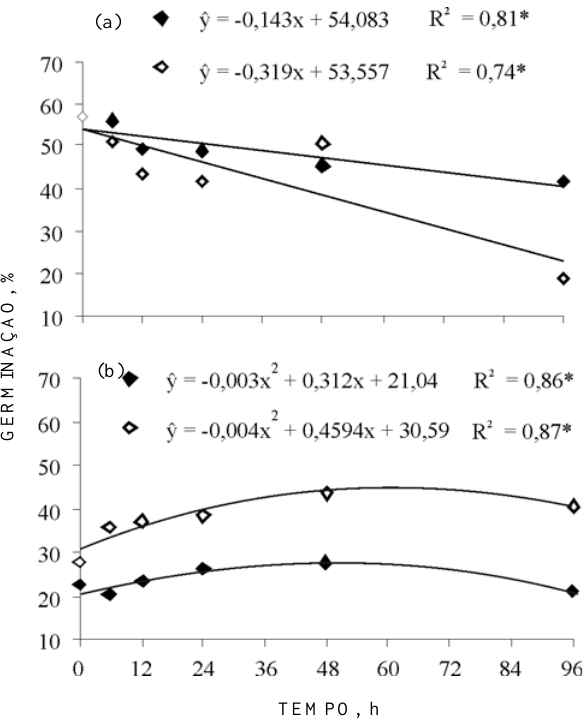
Figura 1. Germinação de sementes de Brachiaria brizantha em razão do período de contato com uréia ( ♦♦♦♦♦ ) e sulfato de amônio ( ◊◊◊◊◊ ), em condições de laboratório (a) e no solo